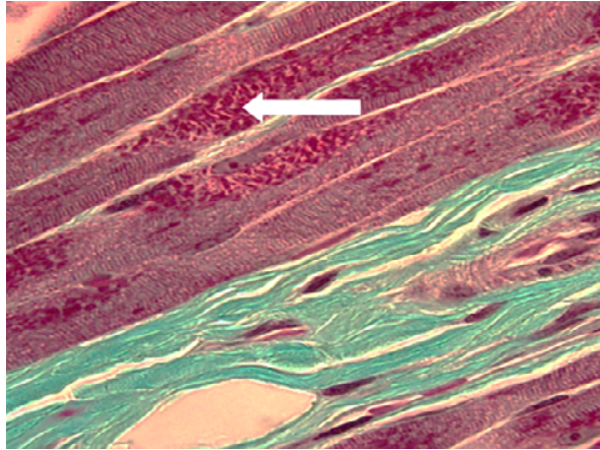
Figure 3a: Modified Gomori trichrome stain on formalin-fixed paraffin- wax embedded left m. triceps brachii biopsied muscle demonstrating the numerous red nemaline rods (arrow) in the sarcolemma of all of the atrophied muscle fibres, in contrast to the green interstitial collagen. Light microscopy, oil immersion, magnification x1000. (Source of images 3a, 3b; 6a, 6b, 6c; 7: June Williams at the Section of Pathology,